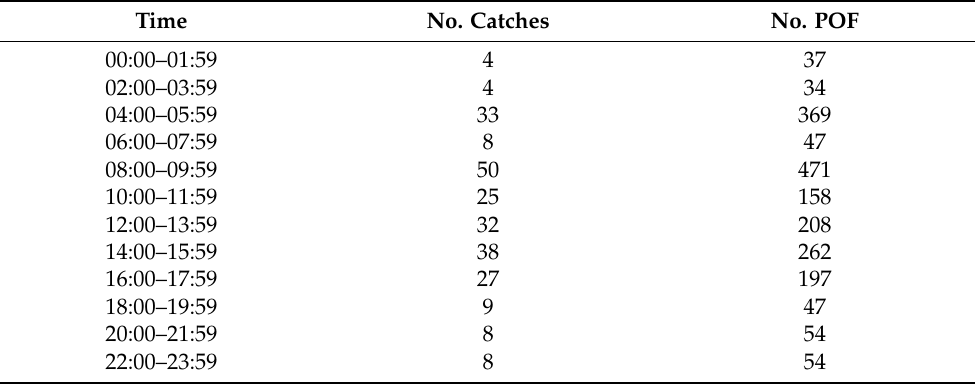
Table 2. Number of catches (No. Catches) and number of postovulatory follicles (No. POF) per two hour-long